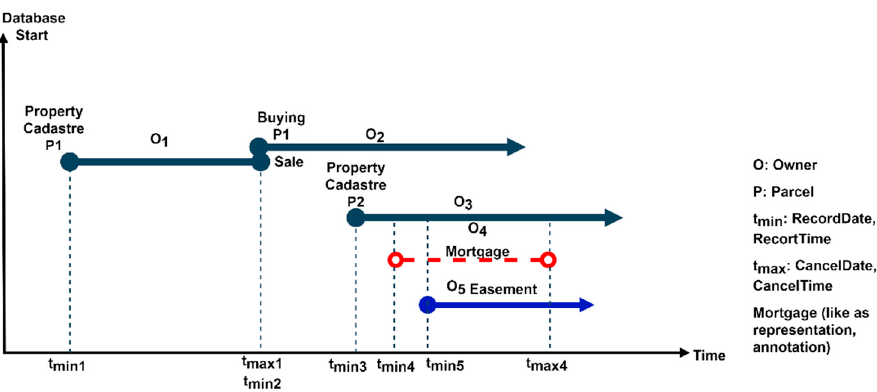
Figure 2. The graphical representation of the transactions of real estate in the Turkish cadastral system over time .